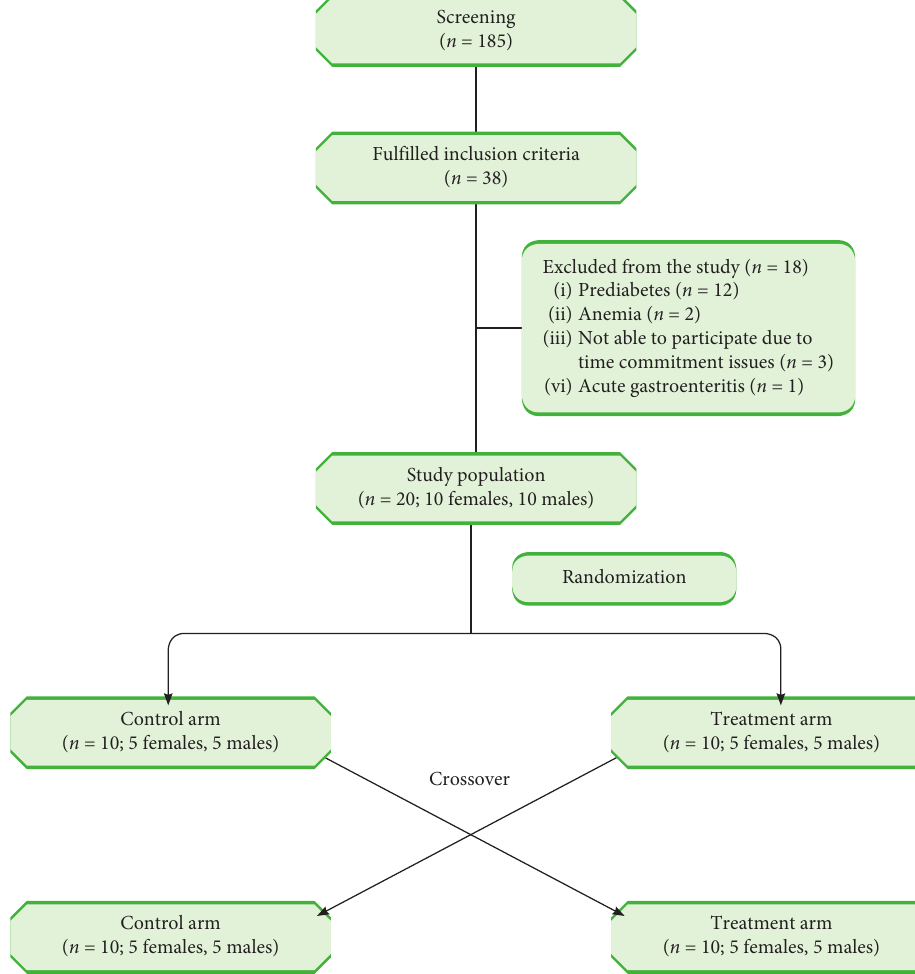
Figure 1: CONSORT diagram of the participant selection